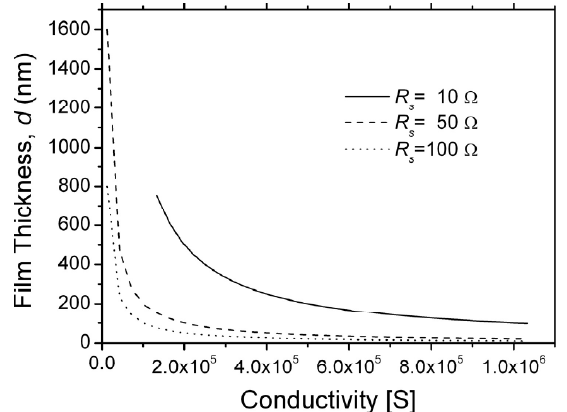
Fig. 1. Fraction of absorbed power as function of TCO conductivity.